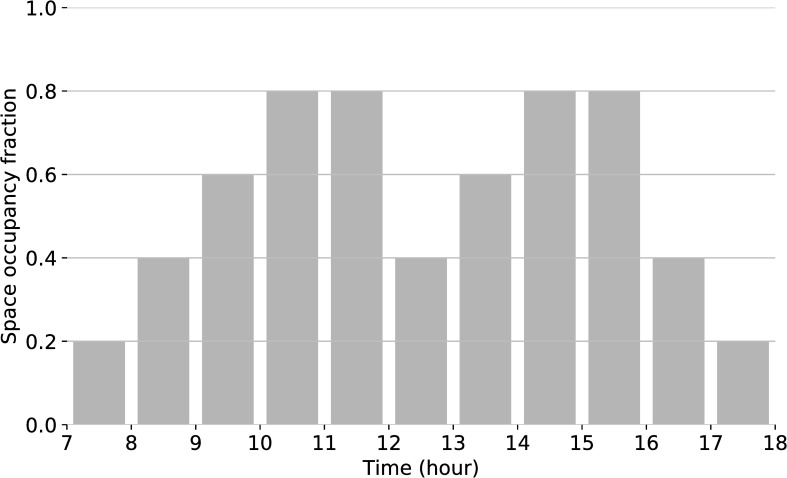
Occupancy schedule for modeling the presence of people in the test room.This schedule is only valid for weekdays. No occupants are present during the weekend.